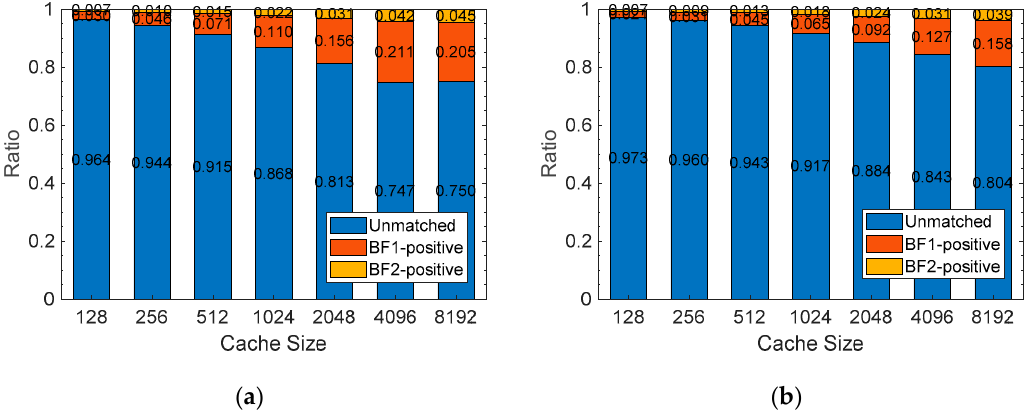
Figure 10. The distribution of cache misses according to their causes. “Unmatched” means there is no matched prefix in a cache, while “BF1-positive” (or “BF2-positive”) means there is a matched prefix but it results in a cache miss due to BF 1 (or BF 2 ) positive: ( a ) in trace-1; and ( b ) in trace-2.